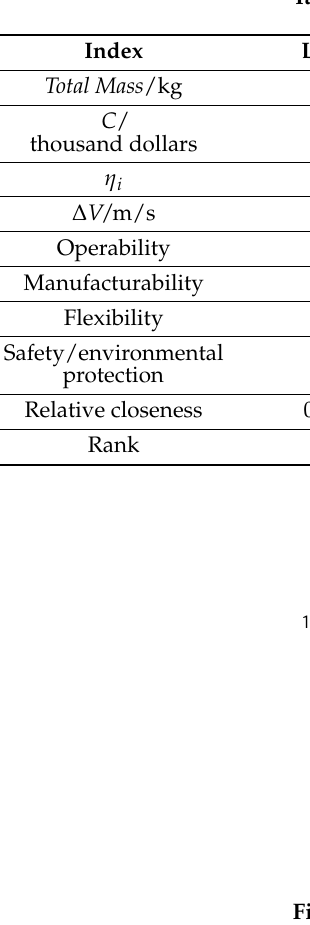
( b ) Figure 15. Internal ballistic simulation results for HRM-TGGF. ( a ) P c - T and F - T ; ( b ) I svac - T and α - T . Table 8. The descent motor mass of HRM-TGGF.